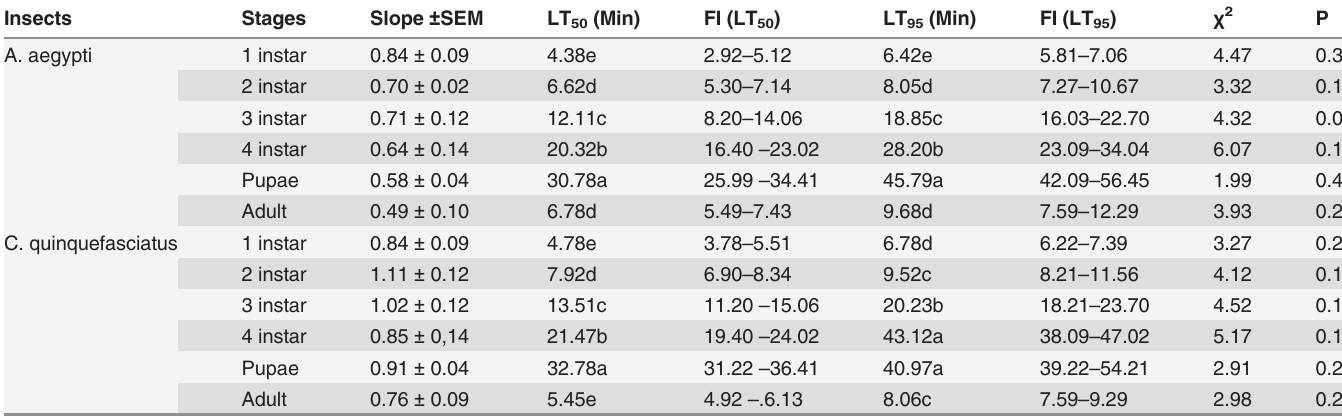
Table 4. LT 50 and LT 95 values of S . guianensis (negramina) essential oils against different developmental stages of A . aegypti and C . quinquefasciatus using the LC 95 .